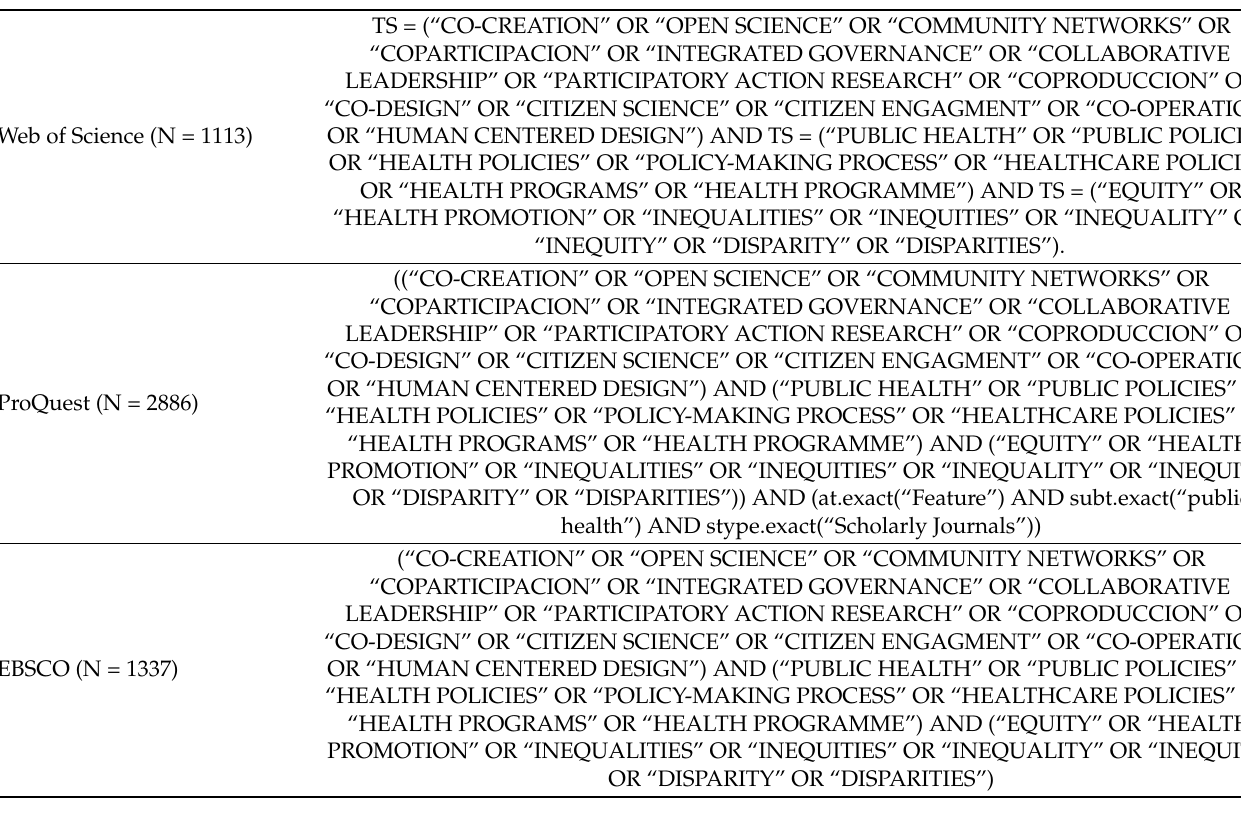
Table A1. Search Equation Used in Each Bibliographic Database to Identify Articles Examining Co-Created Public Health Actions Based on